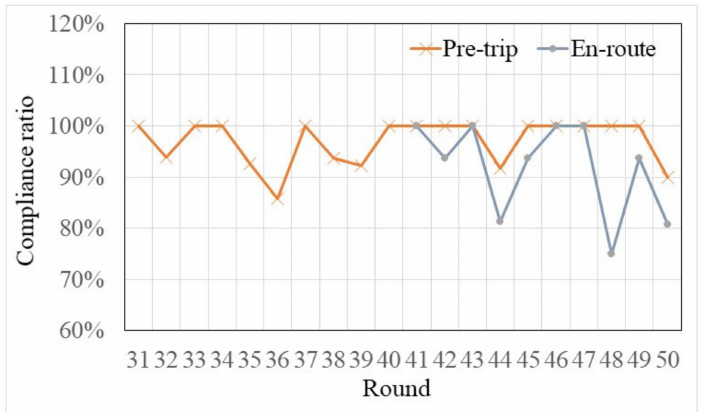
Figure 10. The compliance ratio under the pre-trip and en-route traffic information. (The accuracies of pre-trip traffic information and en-route traffic information were both 90%, i.e., there was a 90% chance that the traffic information recommended the best route equal to the actual